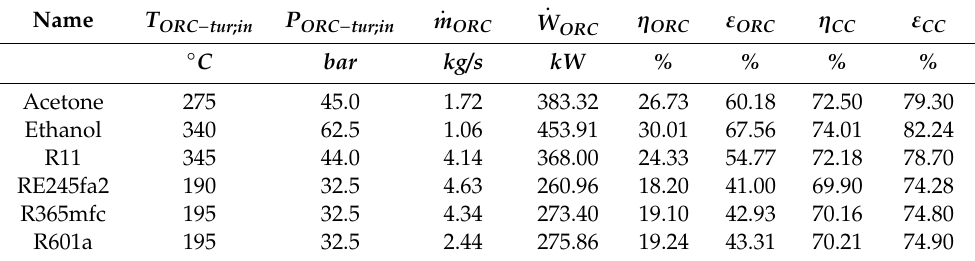
Table 4. The maximum performance obtained cycle parameters for each working